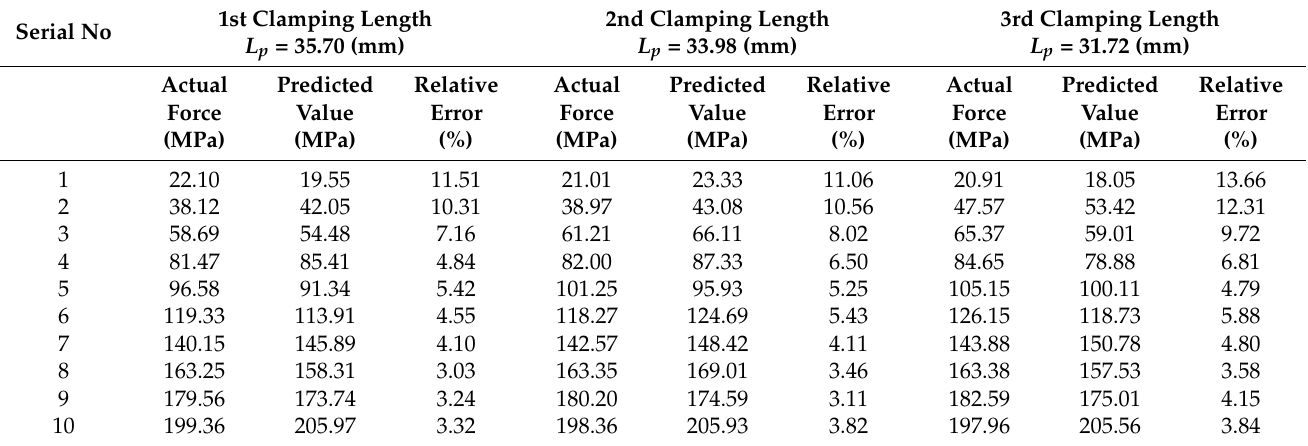
Table 6. Measurement results of axial stress based on the energy attenuation coefficient method.